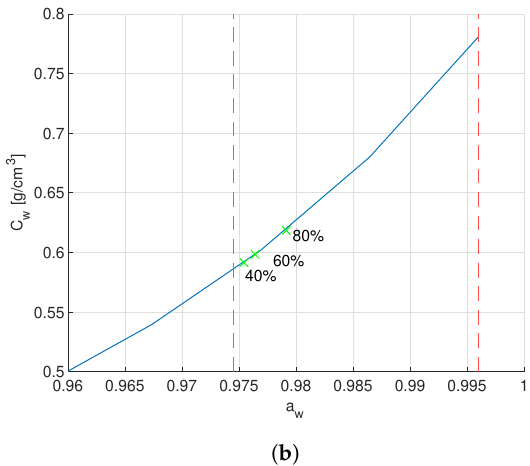
Figure 2. Water concentration and water activity relationship. ( a ) Blue line is the water concentration C w in relation to the water activity a w . The red dashed line on the left marks the water activity at ambient relative humidity of 0% at a w = 0.9745 according to Equations (7) and (8). The red dashed line on the right marks the water activity at ambient relative humidity of 100% at a w = 0.996, which is equal to fully hydrated SC. ( b ) Zoom of the water concentration C w in relation to the water activity a w into the marked range. The three green marks on the blue line indicate the resulting water concentration of the SC exposed to ambient relative humidity of 40%, 60%, and 80% for 30min, see Supplementary